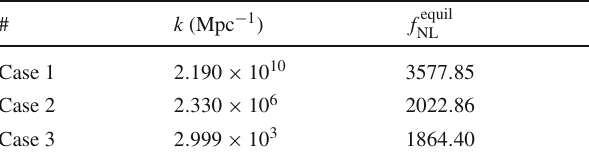
Table 4 The comoving wavenumber and amount of non-Gaussianity parameter for the peak of the equilateral non-Gaussianity in Case 1, 2, and